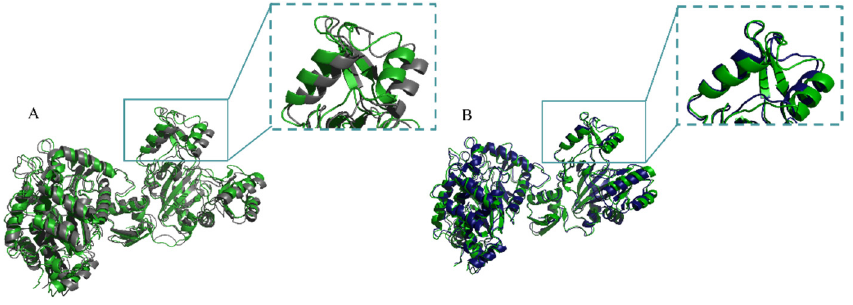
Figure 7. The hydrogen bond analysis. ( A ) The hydrogen bond analysis of WT; ( B ) The hydrogen bond analysis of R270S.